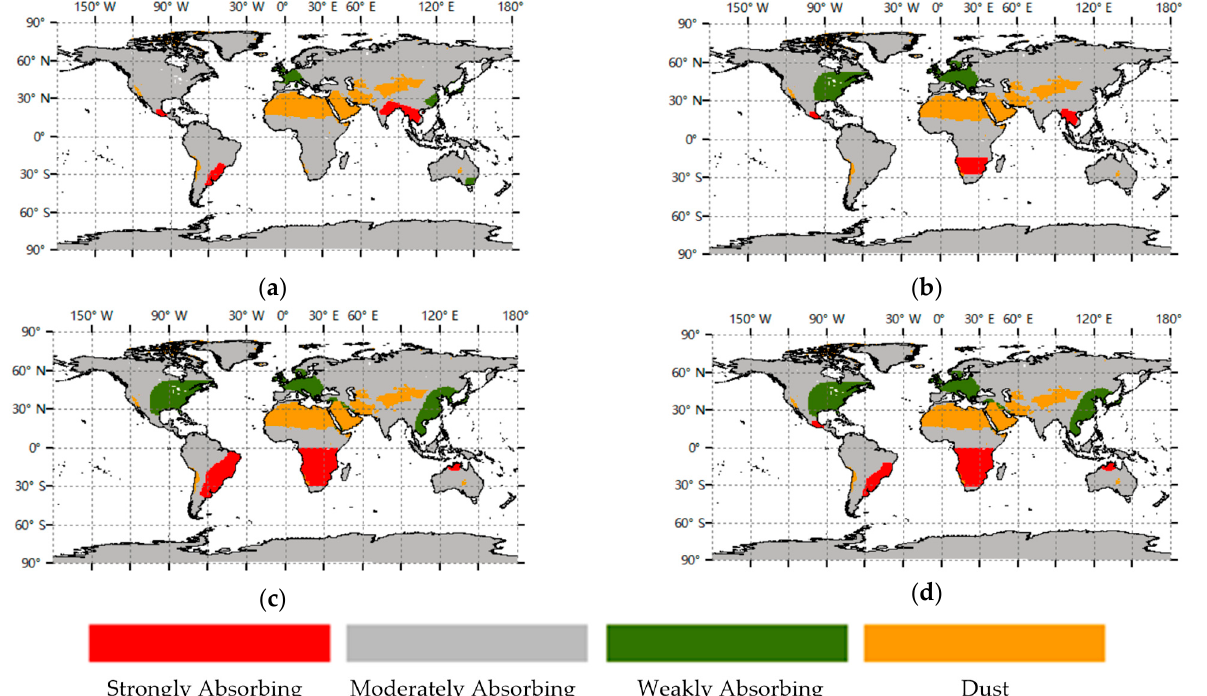
Figure 1. Aerosol types over land used in the ACFrC designated at 1° × 1° grid for different seasons. The four sub-figures show four seasons: ( a ) December, January, and February (DJF); ( b ) March, April, and May (MAM); ( c ) June, July, and August (JJA); and ( d ) September, October, and November (SON).